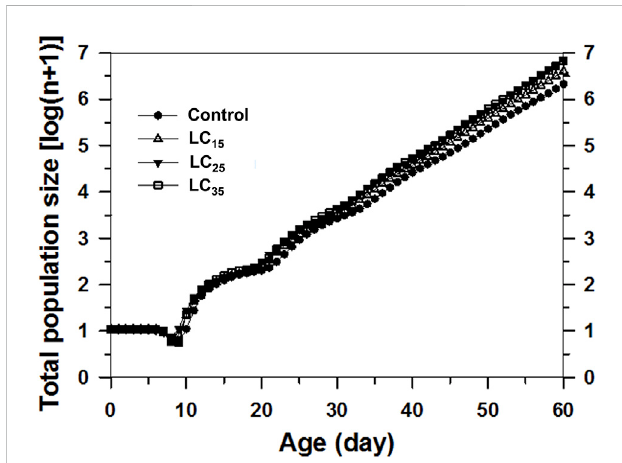
FIGURE 6 Comparison of population projections for Metopolophium dirhodum whose parental females treated with three concentrations of imidacloprid or as the control, based on the age-stage, two-sex life table. The regression formulas describe the linear population growth of each cohort from day 40 onwards as the population approached the stable age-stage